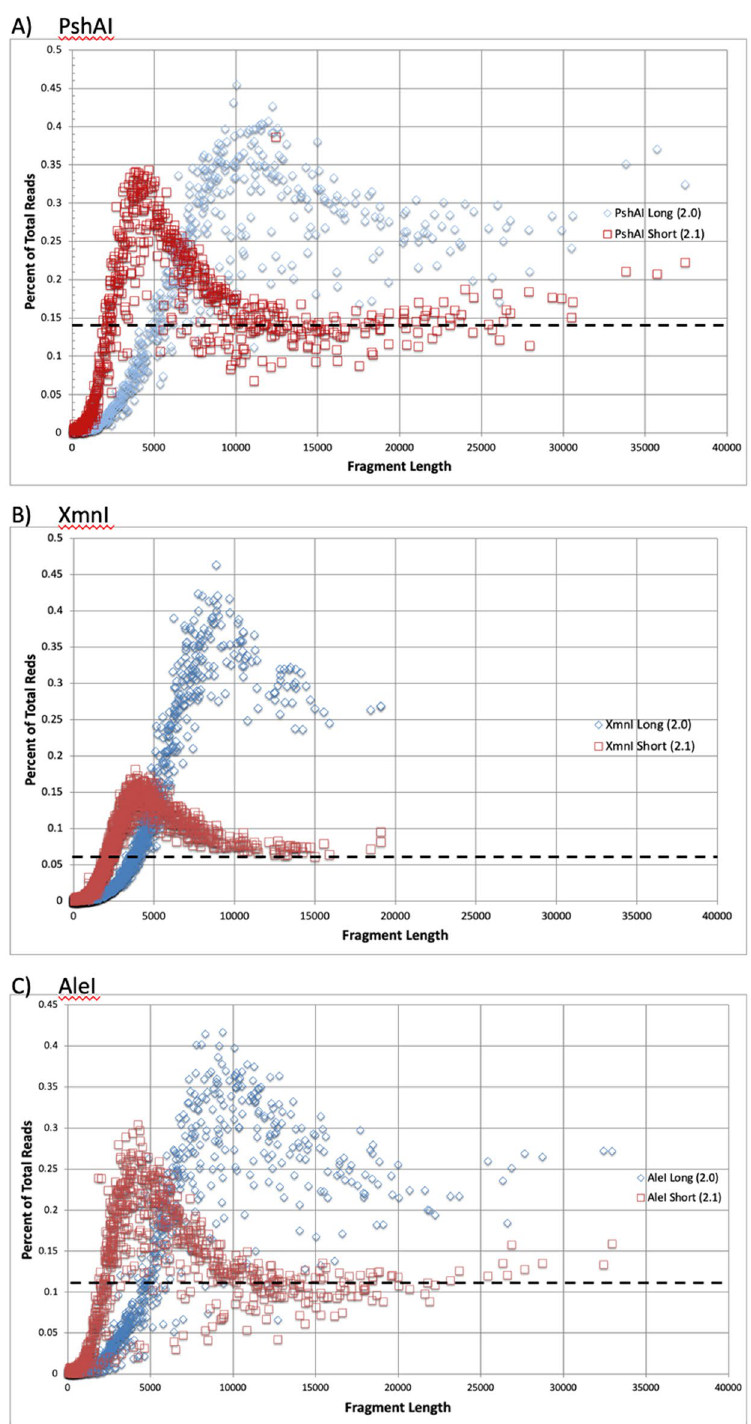
Figure 3. Read frequency as a function of DNA length. The number of reads for each DNA was normalized to the total number of reads for the whole library and then plotted as a function of predicted DNA length. For each enzyme, the short library (protocol 2.1) is shown with red squares and the long library (protocol 2.0) with blue circles. The expected read count for each library if fragment recovery and sequencing were perfect for all fragments is shown by the dashed line in each